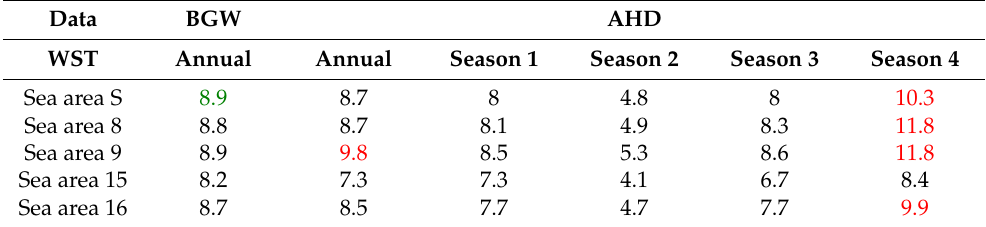
Table 8. Significant wave height (m) at probability of exceedance